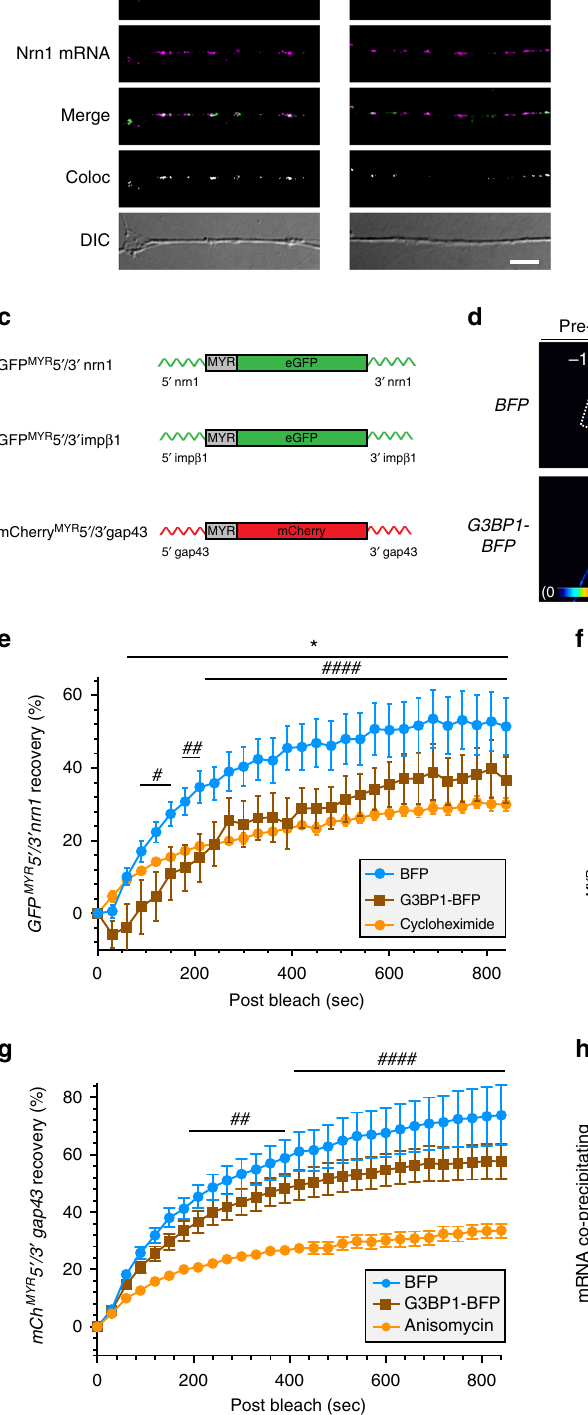
G3BP1-BFP approximated the effect of protein synthesis inhibi- tion for GFP MYR 5 ′ /3 ′ nrn1 and GFP MYR 5 ′ /3 ′ imp β 1 fl uorescence recovery (Fig. 3e – g). Additionally, RNA immunoprecipitation (RIP) analyses showed enrichment of GFP MYR 5 ′ /3 ′ imp β 1 and noprecipitates (Fig. 3h). Taken together, these data suggest